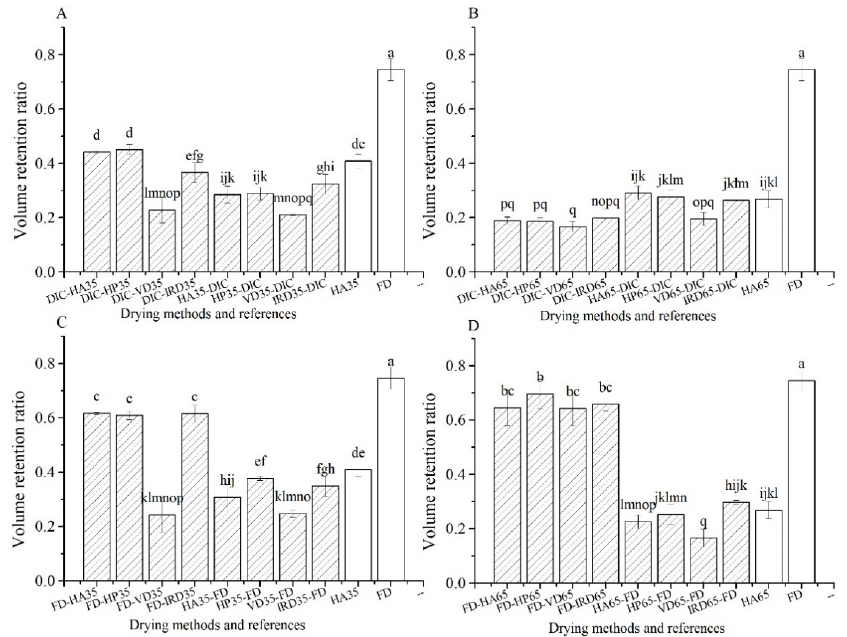
Figure 1. Volume retention ratio of mushrooms, directly after drying, for the different combined Figure 2. Volume recovery ratio of mushrooms after rehydration with different drying methods ( drying methods ( ) and reference methods ( □ ). ( A–D ): group names as shown in Table1. drying methods (